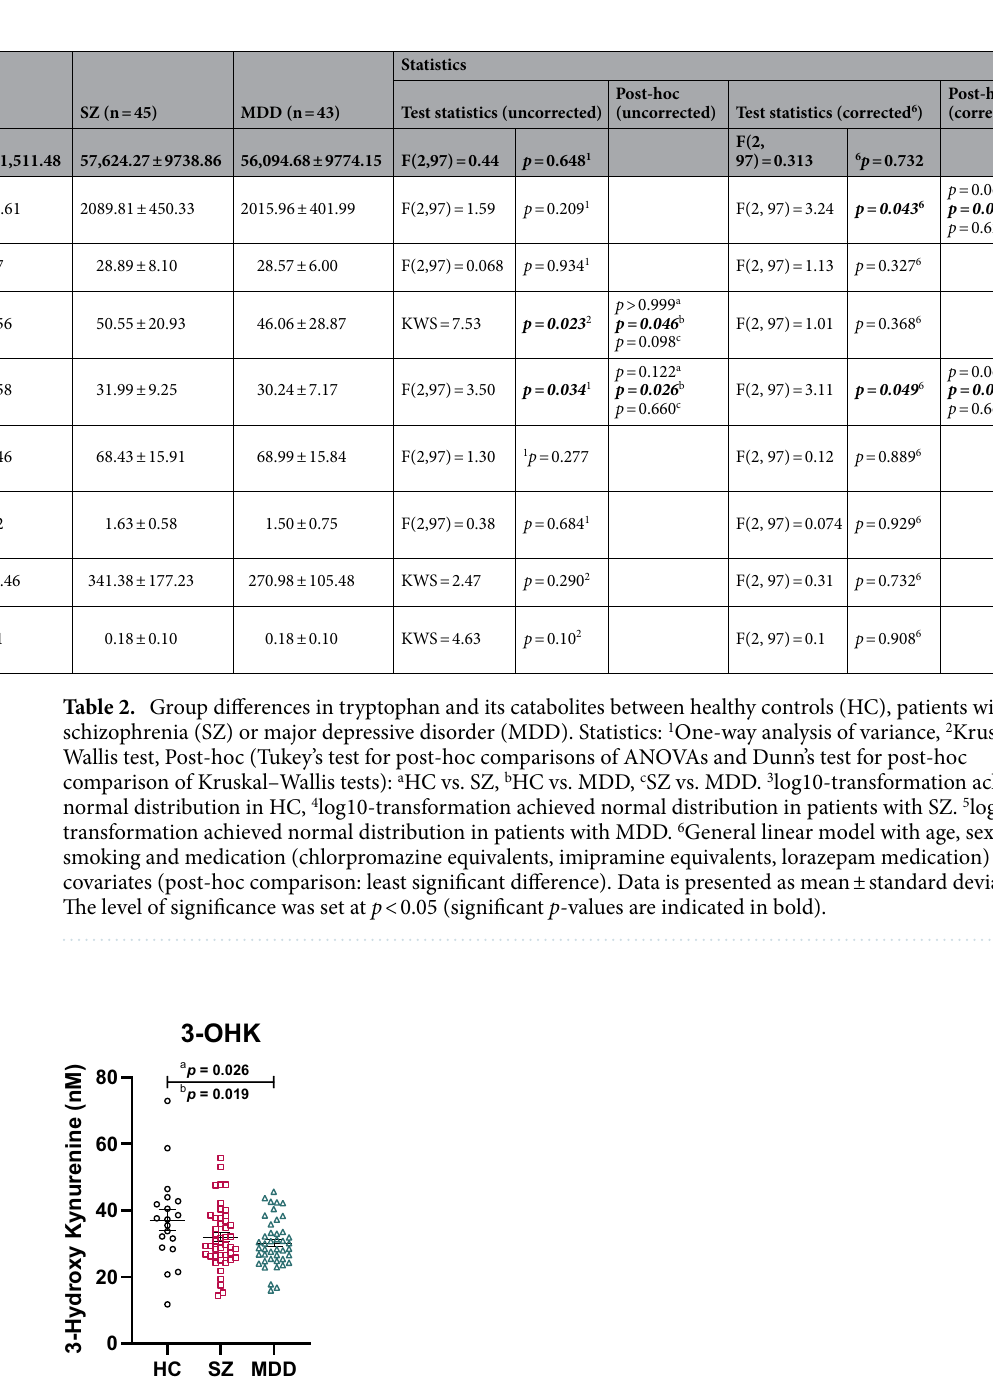
Figure 1. Group differences of 3-hydroxy kynurenine (3-OHK). Compared to healthy controls (HC), patients with major depressive disorder (MDD) but not schizophrenia (SZ) display a reduction in 3-OHK. a Without correcting for covariates, b After correction for the covariates age, sex, BMI, smoking and medication (chlorpromazine equivalents, imipramine equivalents, lorazepam medication). The level of significance was set at p < 0.05 (significant p -values are indicated in